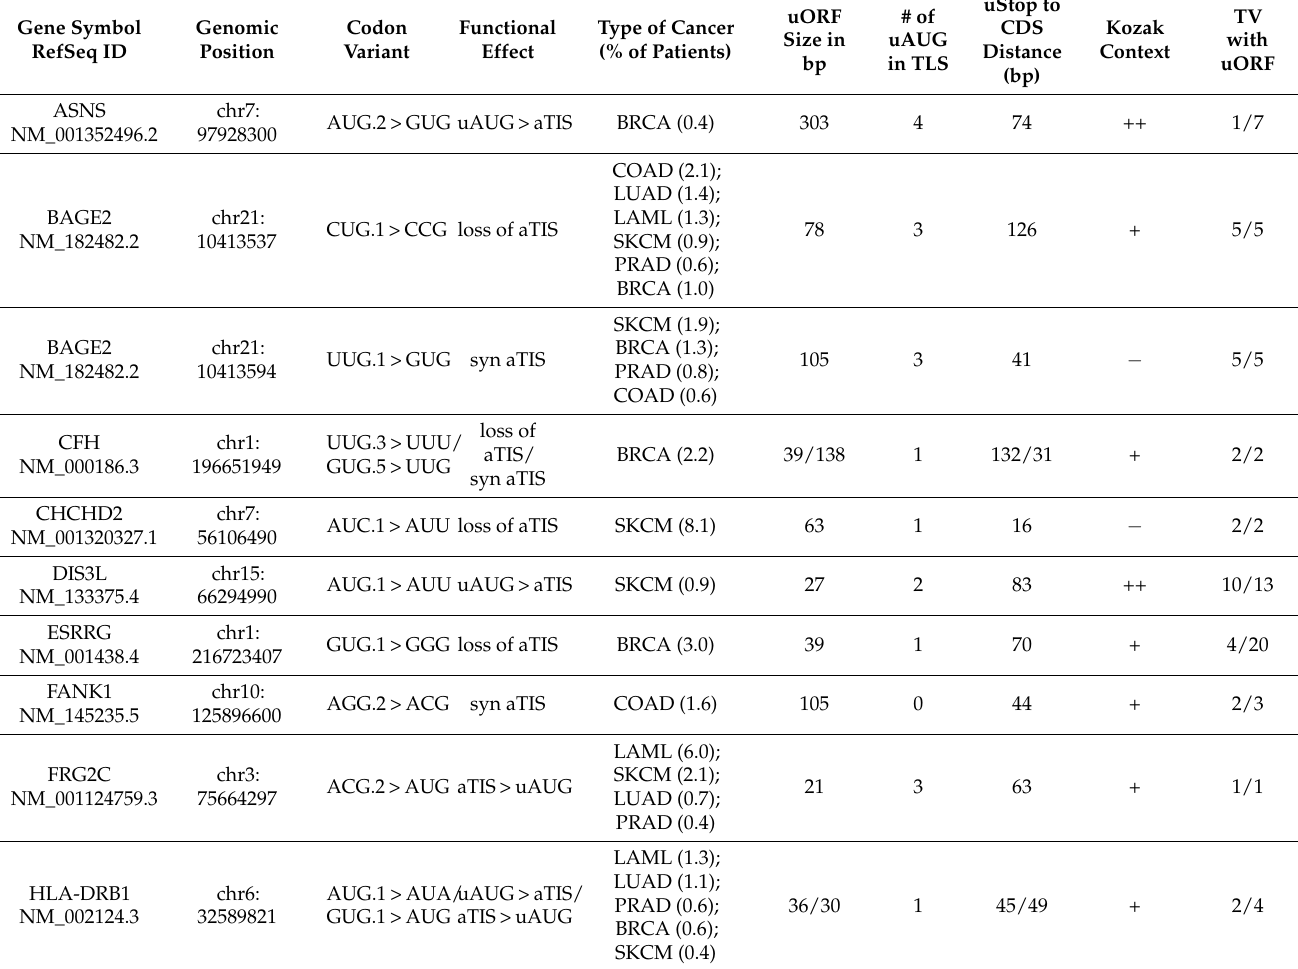
Table 2. List of recurrent somatic SNVs affecting uAUG and aTIS codons selected for experimental analysis. Gene Symbol RefSeq